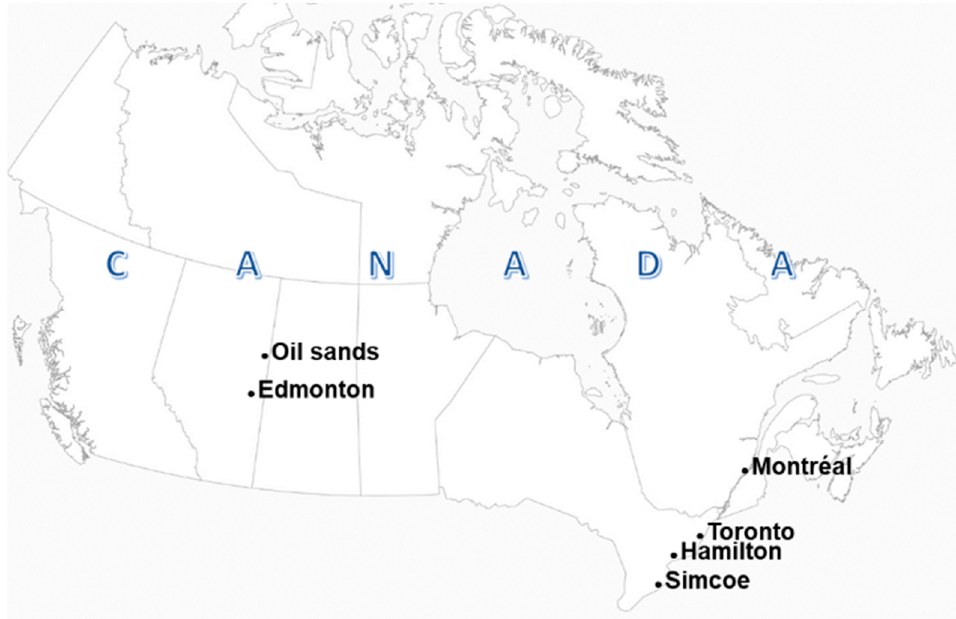
Figure 1. Location of the monitoring sites with reference to the map of Canada. According to the NAPS classification framework, the sampling sites in MTL, HWY401, HMT, and EDM are classified as large urban areas, while SIM is a non-urban site (Table 1). In terms of local land use, the MTL, HMT, and EDM sites are considered residential, HWY401 as a commercial site and SIM as an agricultural site. The near-road site in Toronto is influenced primarily by transportation. It is located in a suburban Toronto area, south of the eastbound lanes of Highway 401 (hereafter referred to as HWY401), one of the busiest highway sections in North America. The residential sites in HMT and EDM are influenced by industrial emission point sources. The HMT site is influenced by nearby steel making industry and heavy machinery and transportation which supports this industry. The EDM site is located in a residential area potentially influenced by residential heating, within a few kilometers of a freeway and near petrochemical refineries. The MTL site is located in a suburban borough at the eastern end of the Island of Montr é al. It is considered a general population exposure site, and like EDM is potentially influenced by residential heating activities during colder periods and by local traffic. The regional background site in SIM is situated near agricultural-based